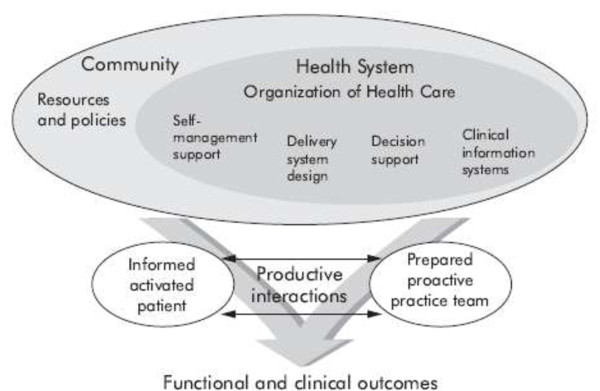
Wagner's Chronic Care Model [3].